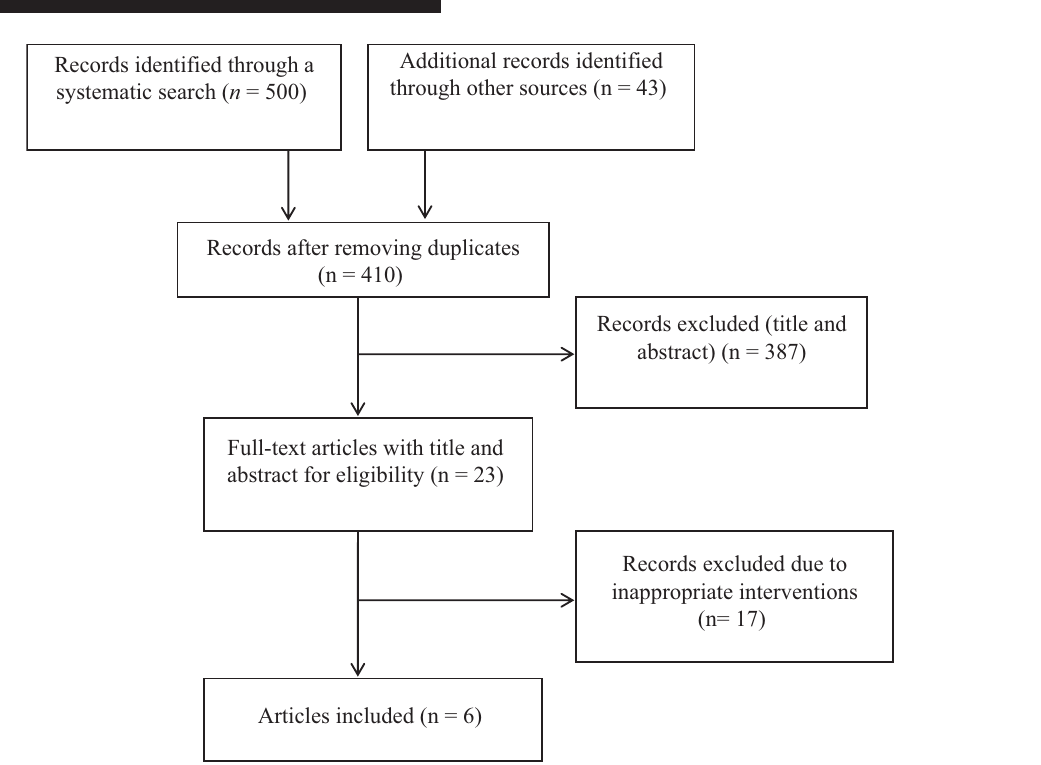
Figure 1. Flowchart of the study selection and inclusion process.